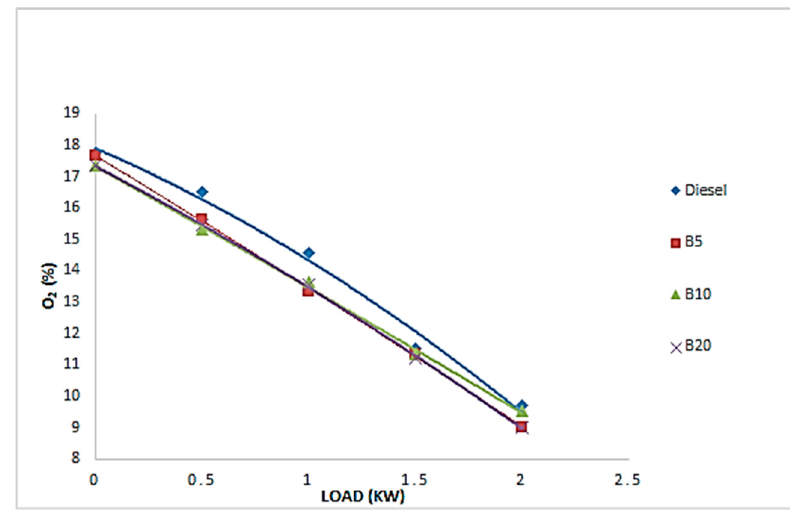
Figure 11. Variation in O 2 with respect to load.